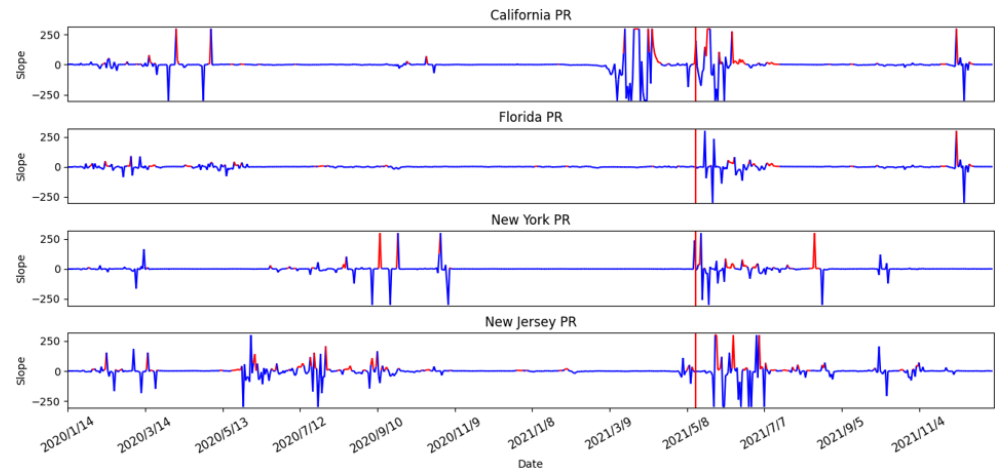
Figure 25. The result of risk analysis with PR of four